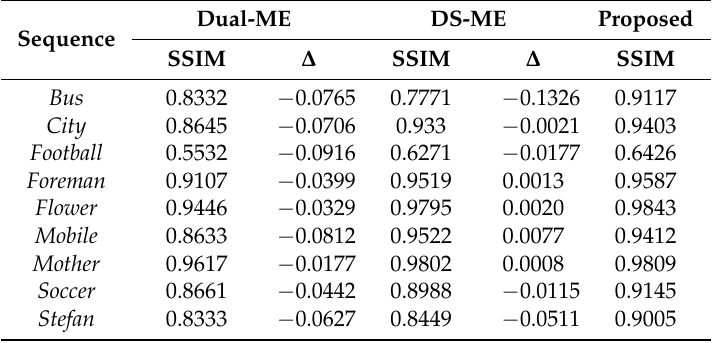
Table 2. The Structural SIMilarity (SSIM) comparison of different ME methods for the test sequences. Dual-ME Sequence